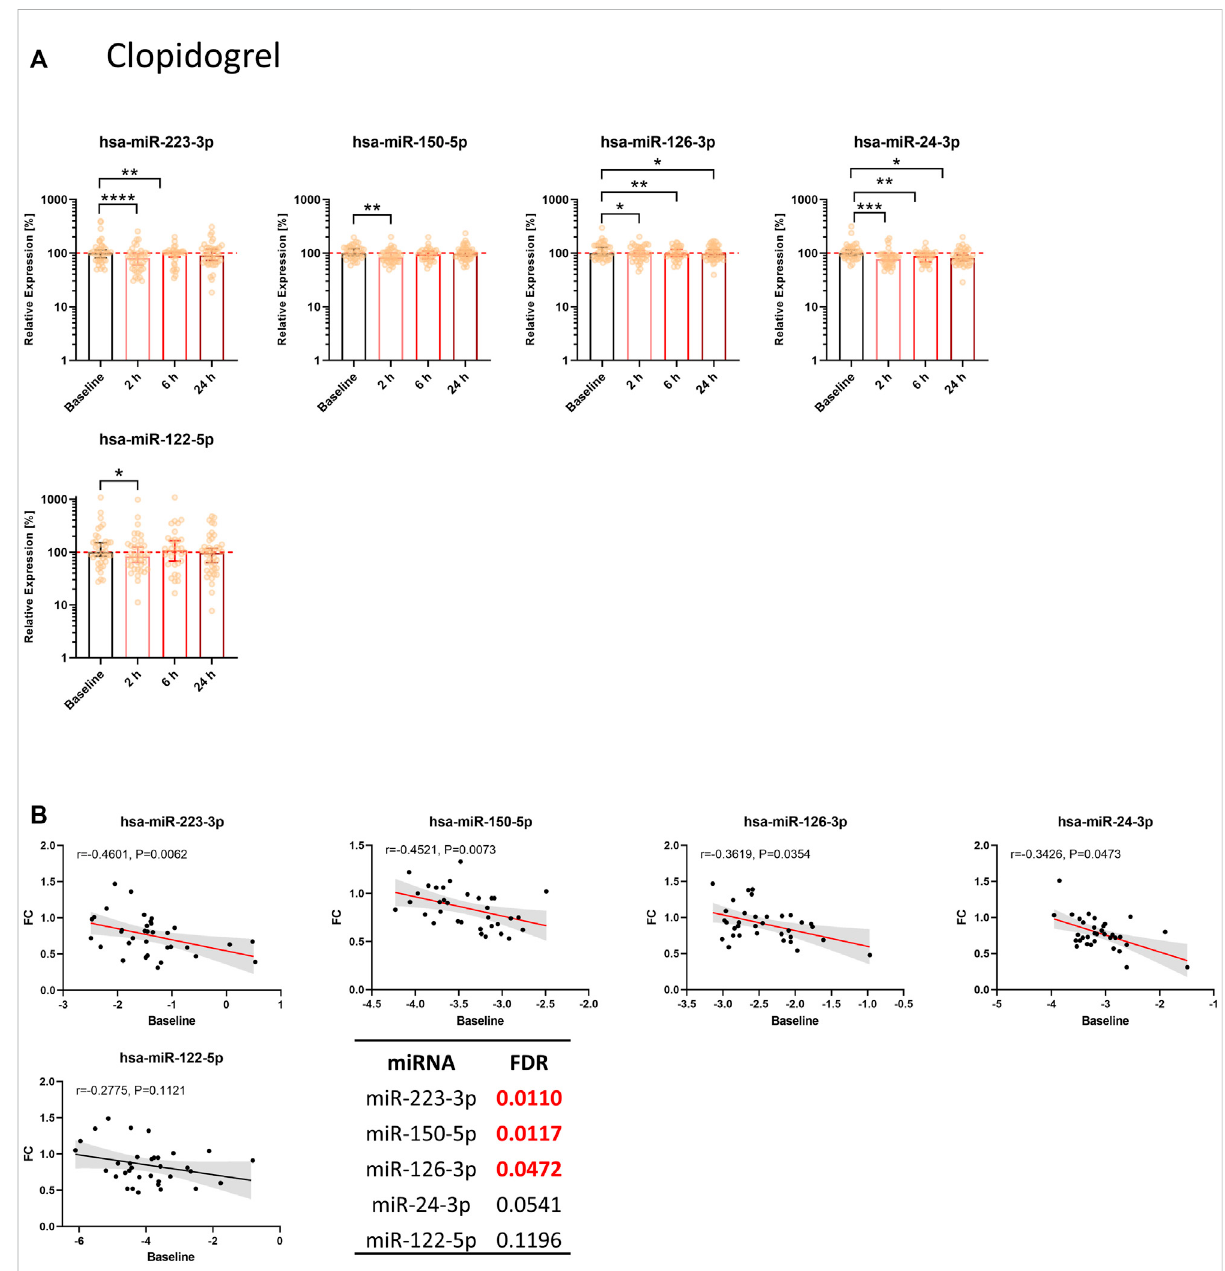
FIGURE 3 CirculatinglevelsofmiRNAsfromthethrombomiRpanelaresigni fi cantlyreduceduponclopidogrel-mediatedinhibitionofplateletfunction. (A) MiRNA levels in subjects treated with clopidogrel. Values represent the relative expression of UniSp4 normalized Cq values that were linearized ( ΔΔ Cq, % of the median of baseline samples). Friedman test with Dunn ’ s multiple comparisons test was calculated. Donors with missing values were removed from statistical analysis but not from depiction in graphs. (B) Baseline miRNA levels were correlated with the FC of the decrease 2 h after onset of clopidogrel treatment. Correlations were calculated using the Spearman test, reporting the Spearman rank coef fi cient (r) and unadjusted p -value (P). A line was fi t to the data applying simple linear regression. Multiple testing adjusted p -values are reported as FDR for each miRNA. FDR-values < 0.05 were considered statistically signi fi